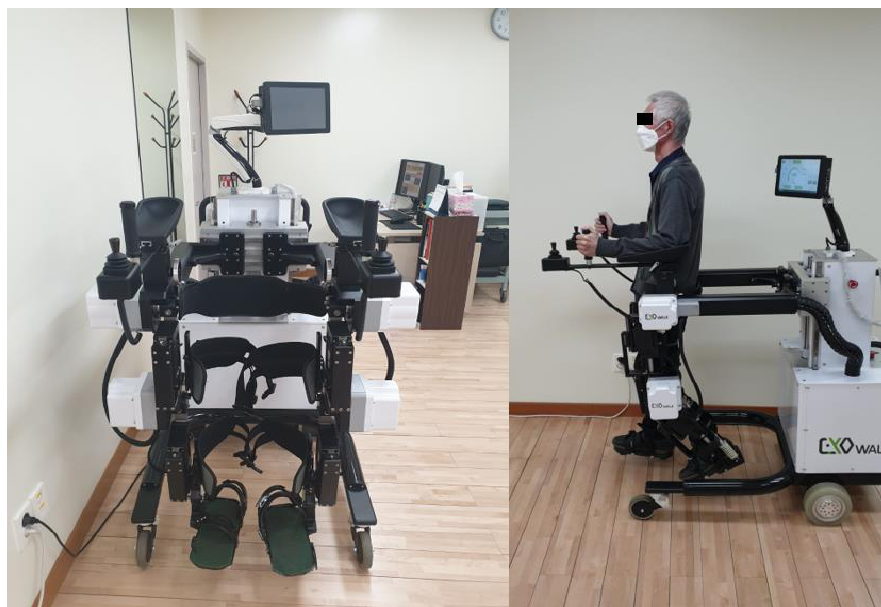
Figure 2. The EXOWALK ® (HMH, Incheon, South Korea) exoskeletal-type robot.